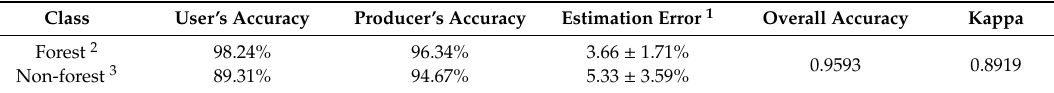
Table 3. Accuracy validation of forest / non-forest classification result based on 10 m